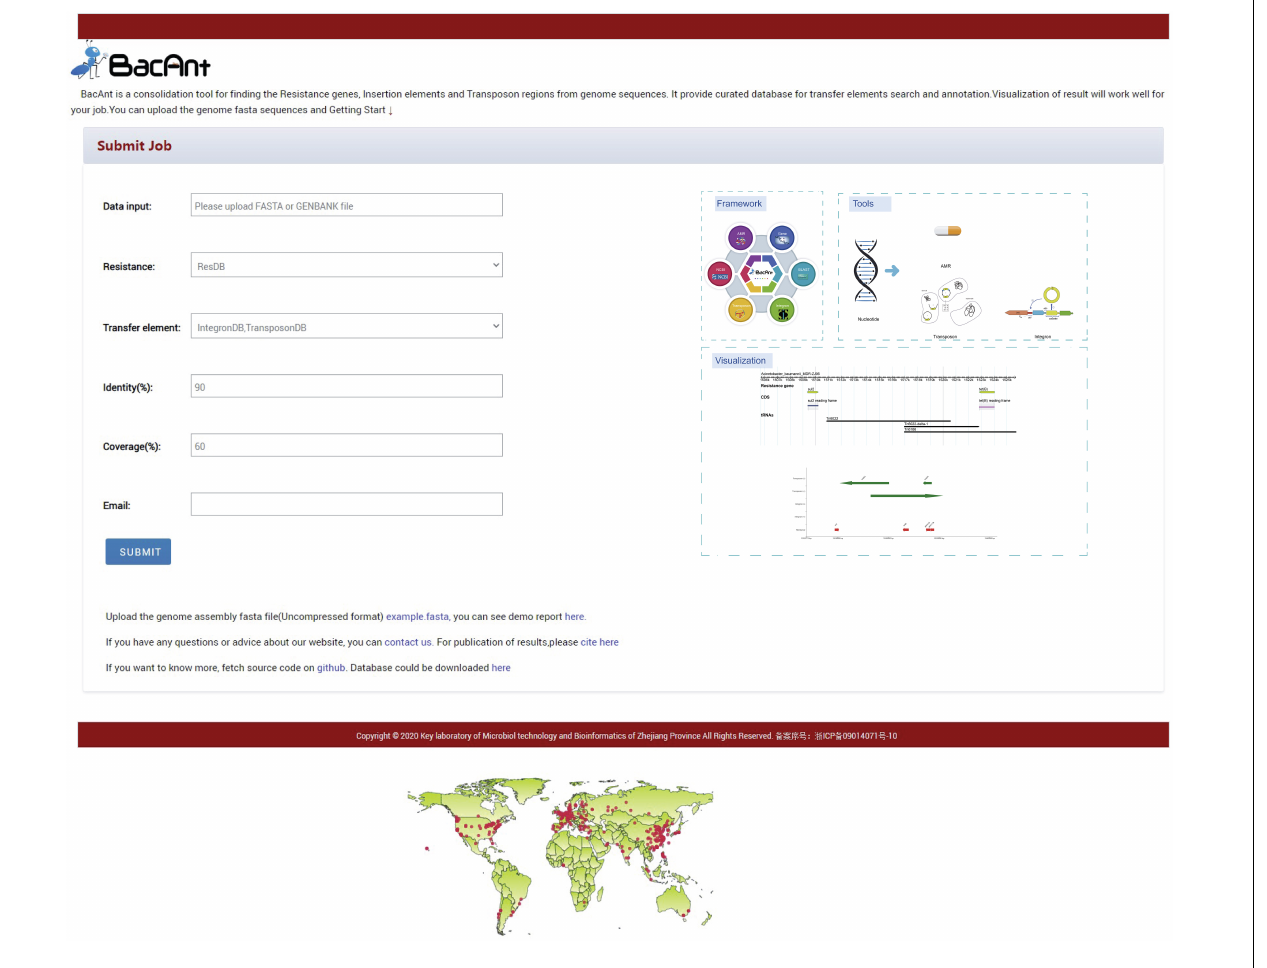
Frontiers in Microbiology |